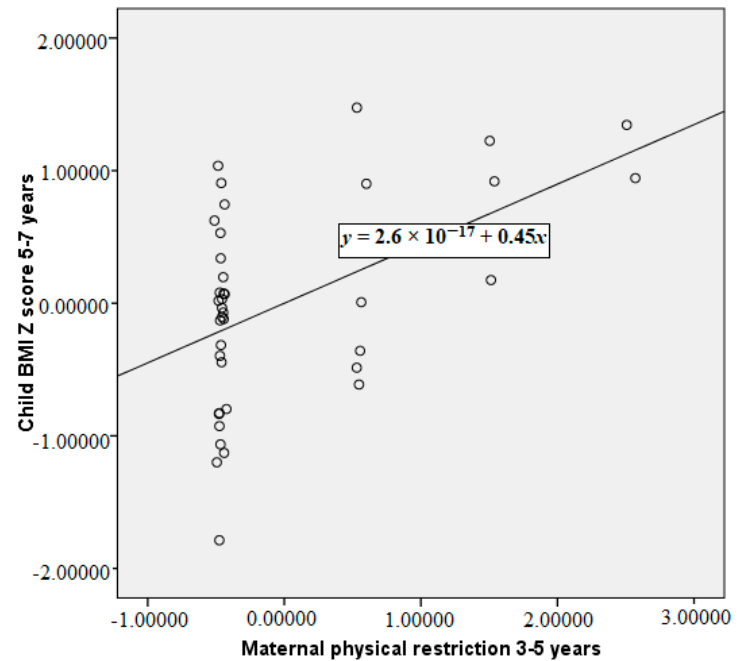
Figure 2. Partial correlation between maternal physical restriction at 3–5 years and child BMI Z-score at 5–7 years, controlling for child BMI Z-score at 3–5 years (plot of the unstandardised residuals).